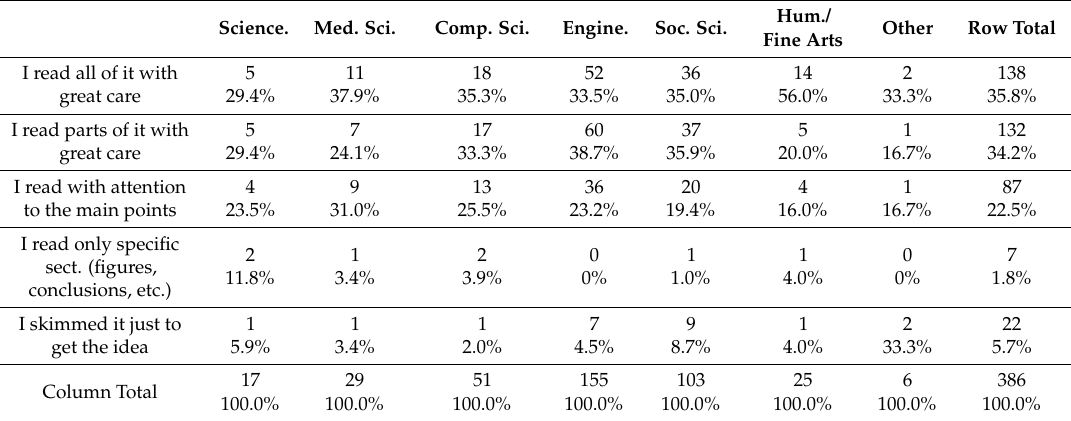
Table 10. Thoroughness of article reading by subject disciplines groups.